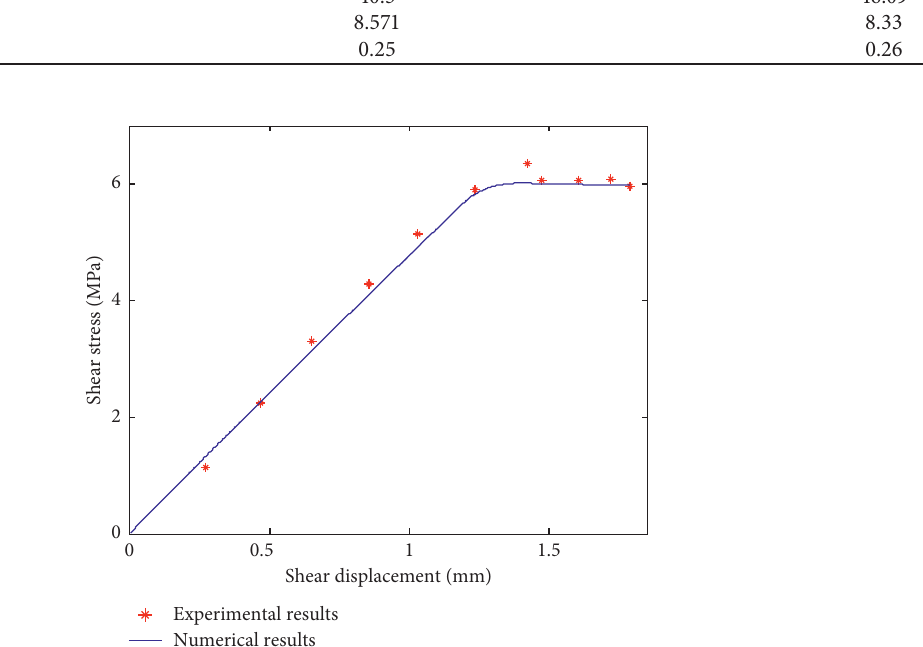
Figure 12: Comparison between the experimental result reported by Moosavi and Bawden [25] and the numerical simulation